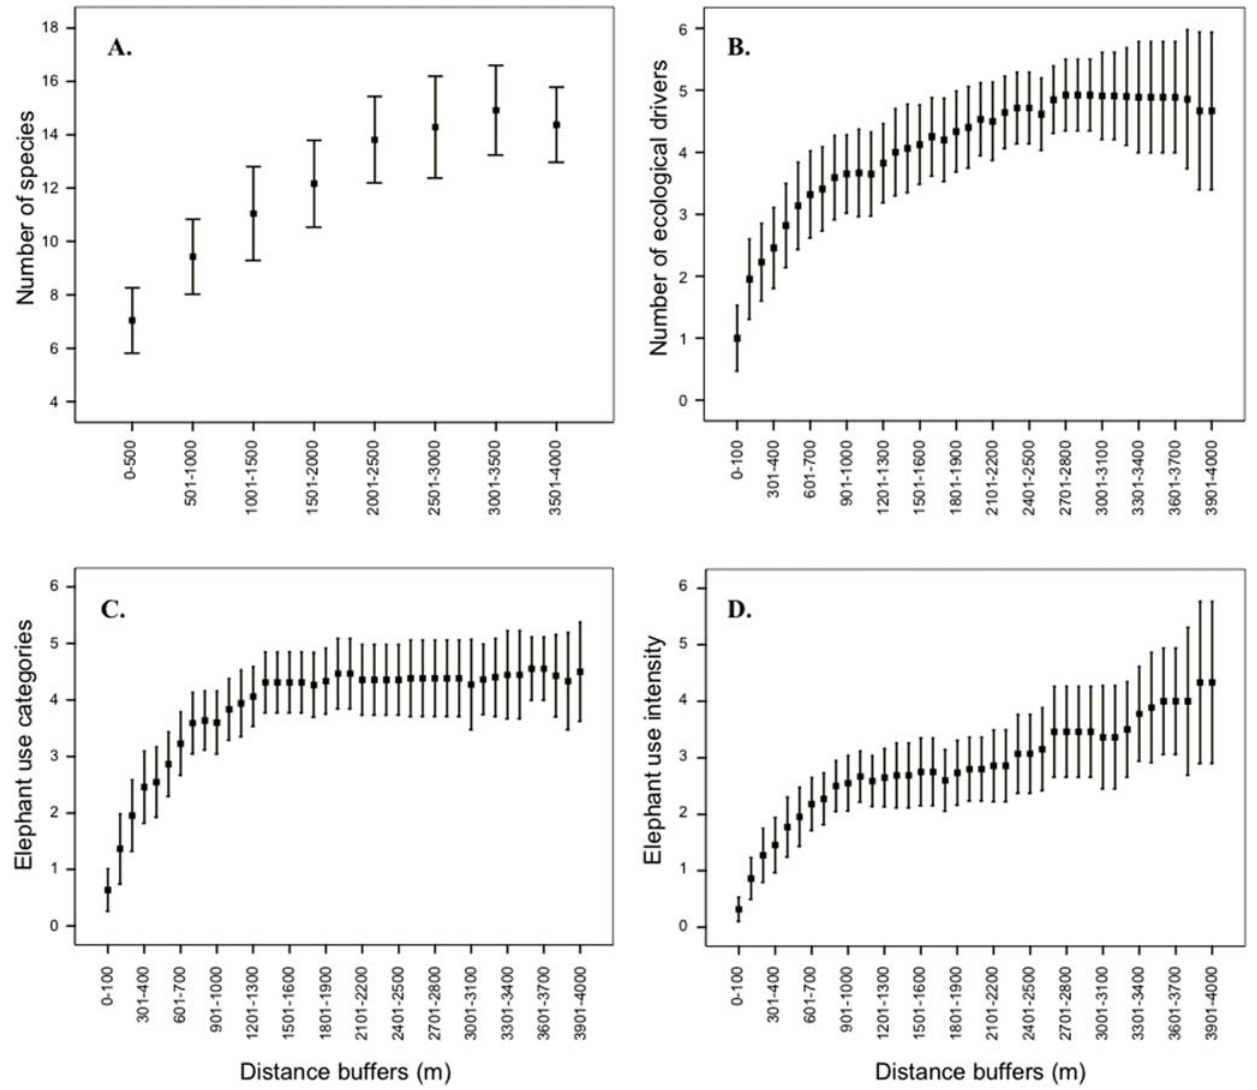
Figure 1. A measure of effectiveness for monitoring ecological impact on large trees. (a) Accumulation curve (mean 6 95% confidence limits) of tree species within increasing 500 m buffers to determine optimal distance (observed as the point at which the dependent variable levels off) to sample all tree species. Increasing 100 m buffers were used to produce accumulation curves to determine the optimal distance to sample all (b) ecological drivers, (c) elephant use categories and (d) elephant intensity of use